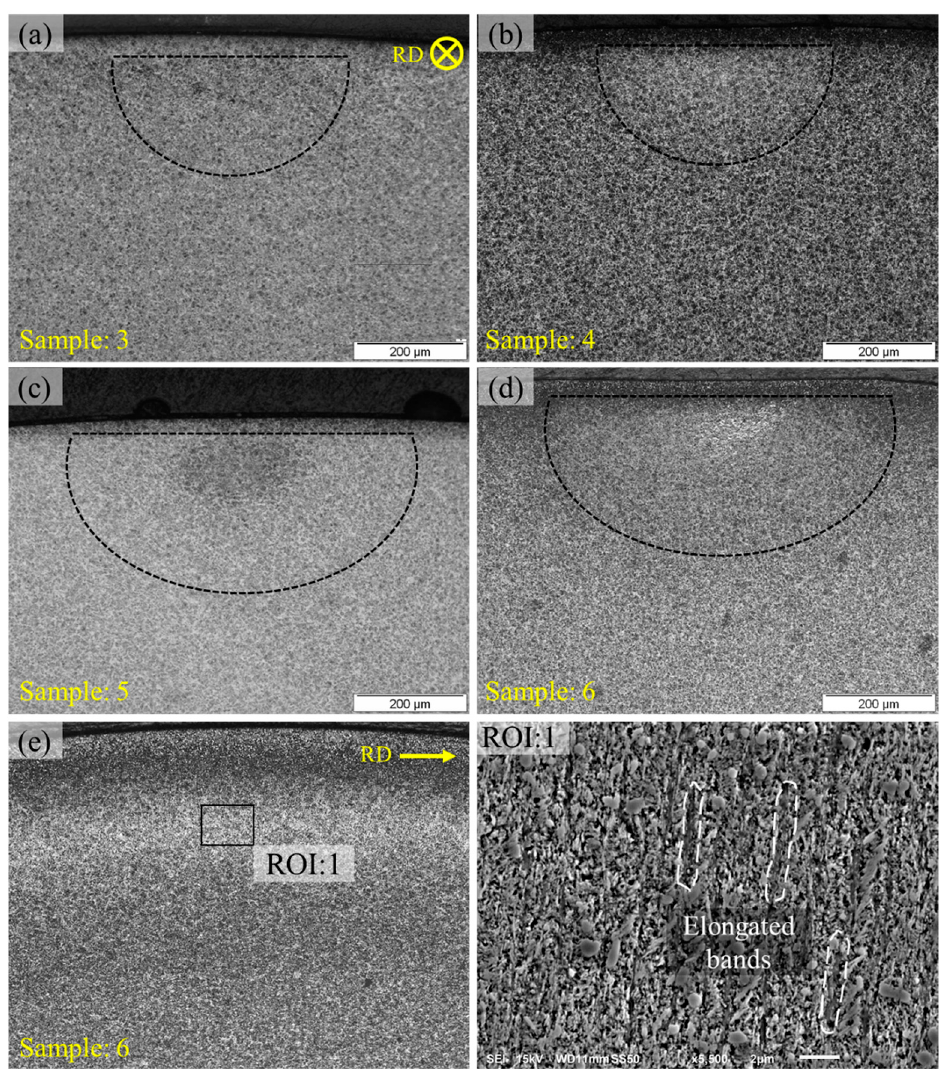
Figure 3. ( a ) Untempered and ( b ) tempered RCF ‐ tested sample at 4 GPa, 100 °C, 4051 rpm. ( c ) Untempered and ( d ) tempered RCF ‐ tested samples at 5 GPa, 100 °C, and 4051 rpm. The inset of circumferentially sliced sample ( e ) is shown in ROI:1.